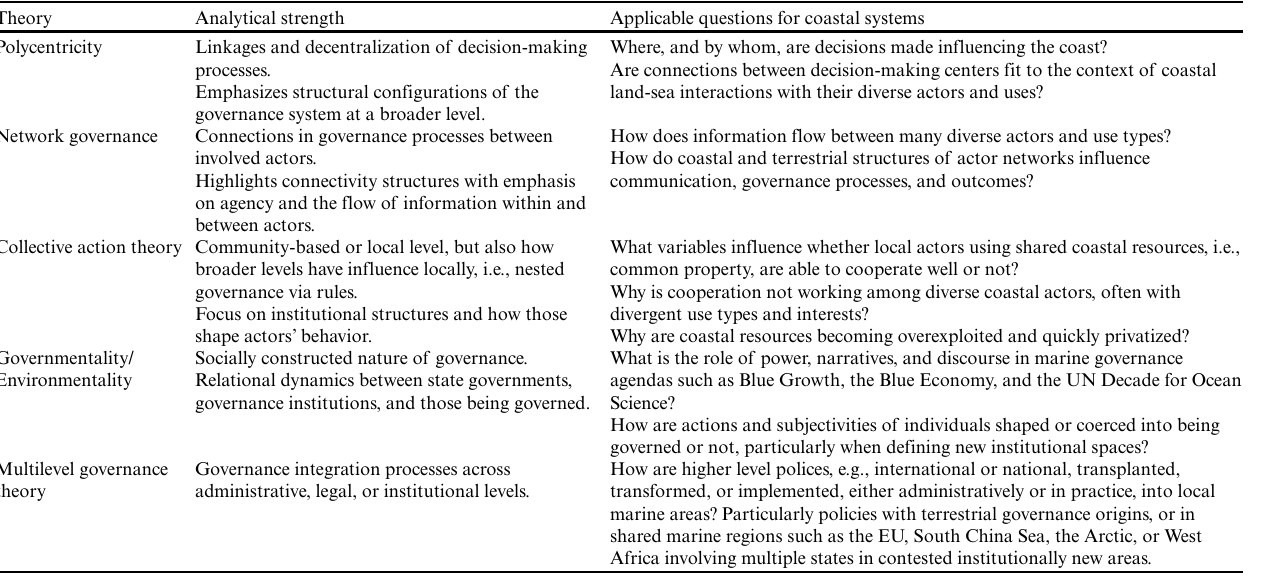
Table 2 . Focused theories. Their brief analytical strength and when they could be applied to coastal systems and beyond. Theory Analytical strength Applicable questions for coastal systems